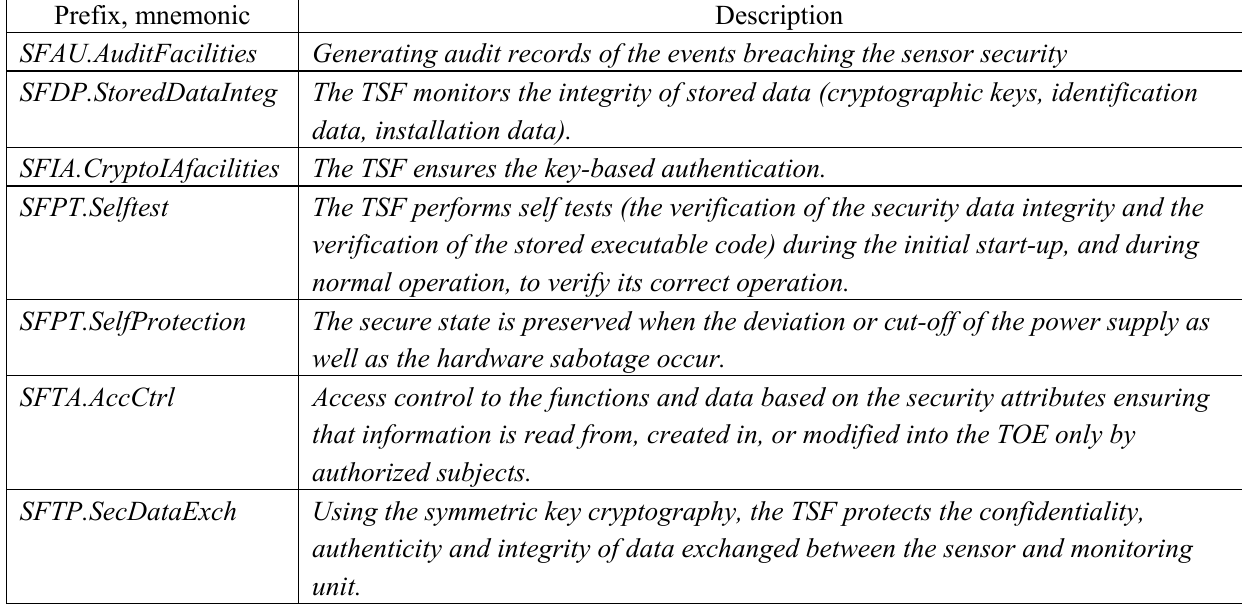
Table 16. TOE security functions—examples related to the motion sensor project [16]. Prefix,